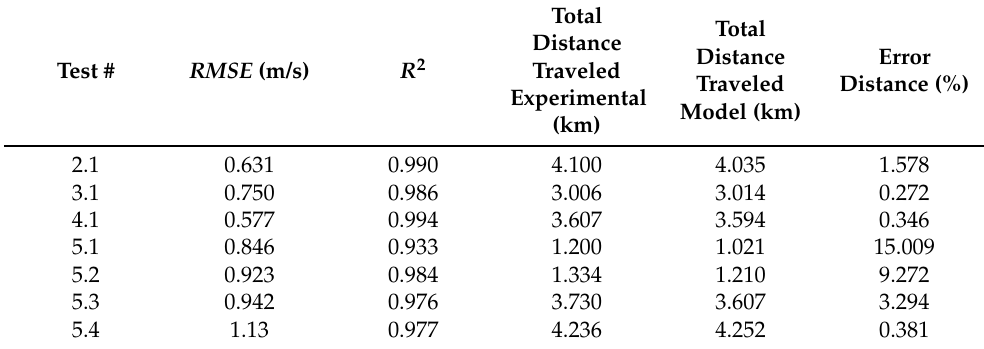
Table 12. Prediction metrics of vehicle model performance over parameter identification datasets.